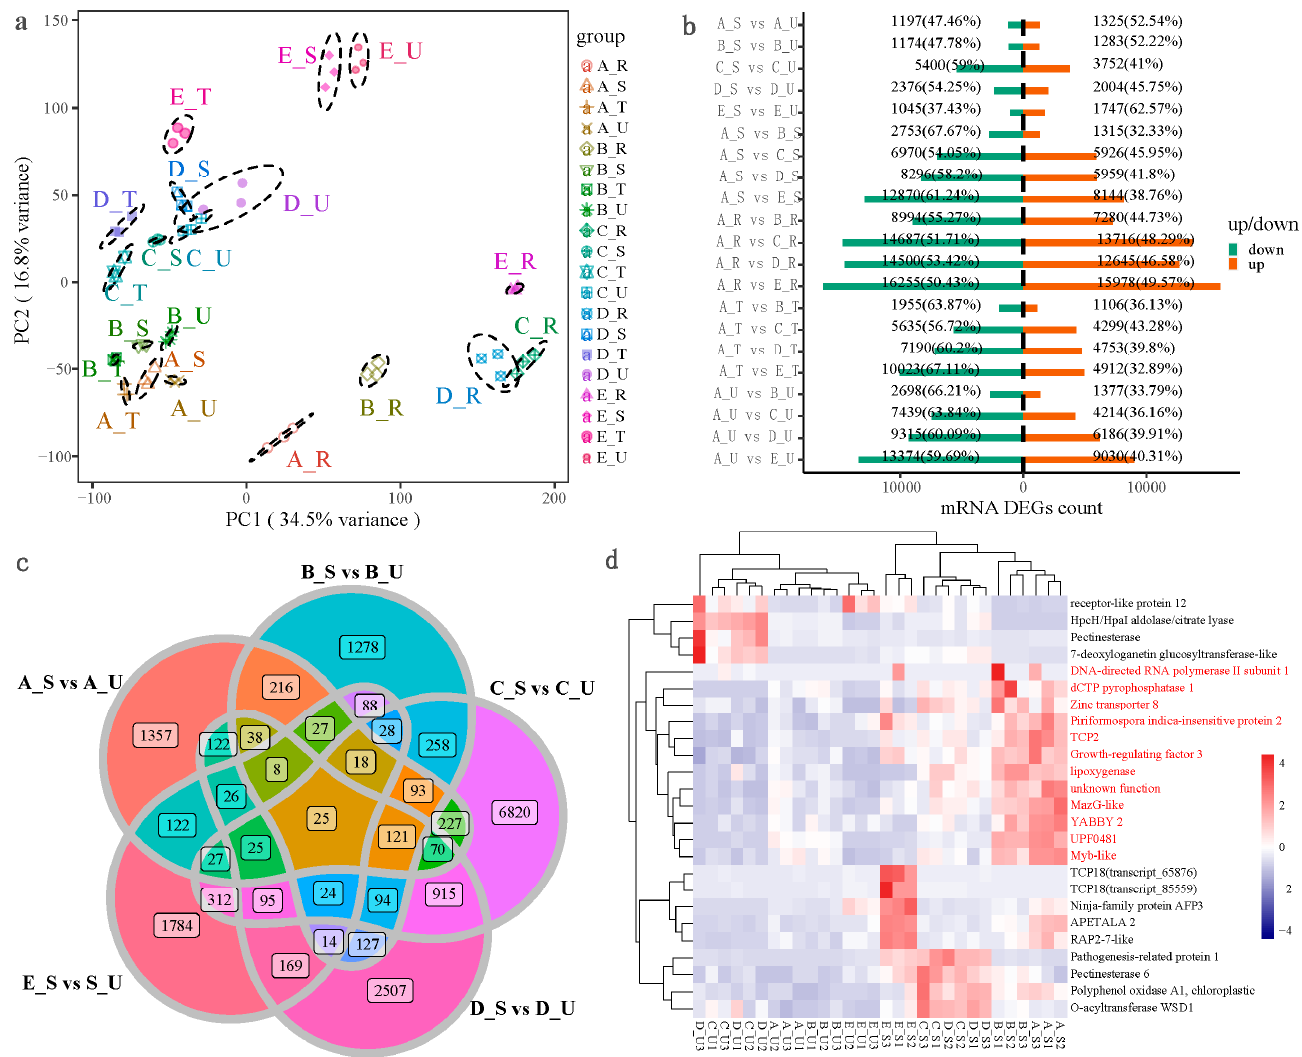
Figure 2. Sample PCA analysis and quantitative analysis of DEGs. ( a ): PCA analysis; ( b ): quantitative analysis of DEGs in different combinations; ( c ): venn analysis of different combinations; ( d ): heat map analysis of DEGs. Note: Different combinations in figure a were distinguished by color and shape, and the circles represented 95% confidence intervals; the texts in ( b ) were the number and proportion of up-regulated or down-regulated in one group.